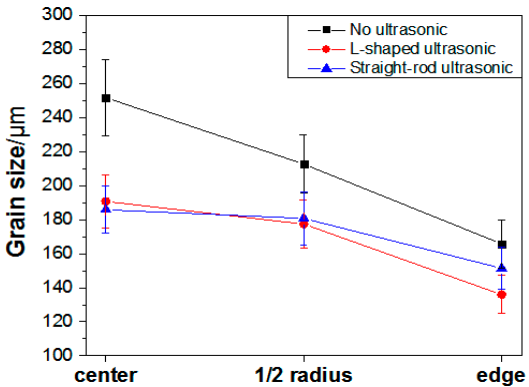
Figure 6. Distribution of grain size of ingots under different processing conditions